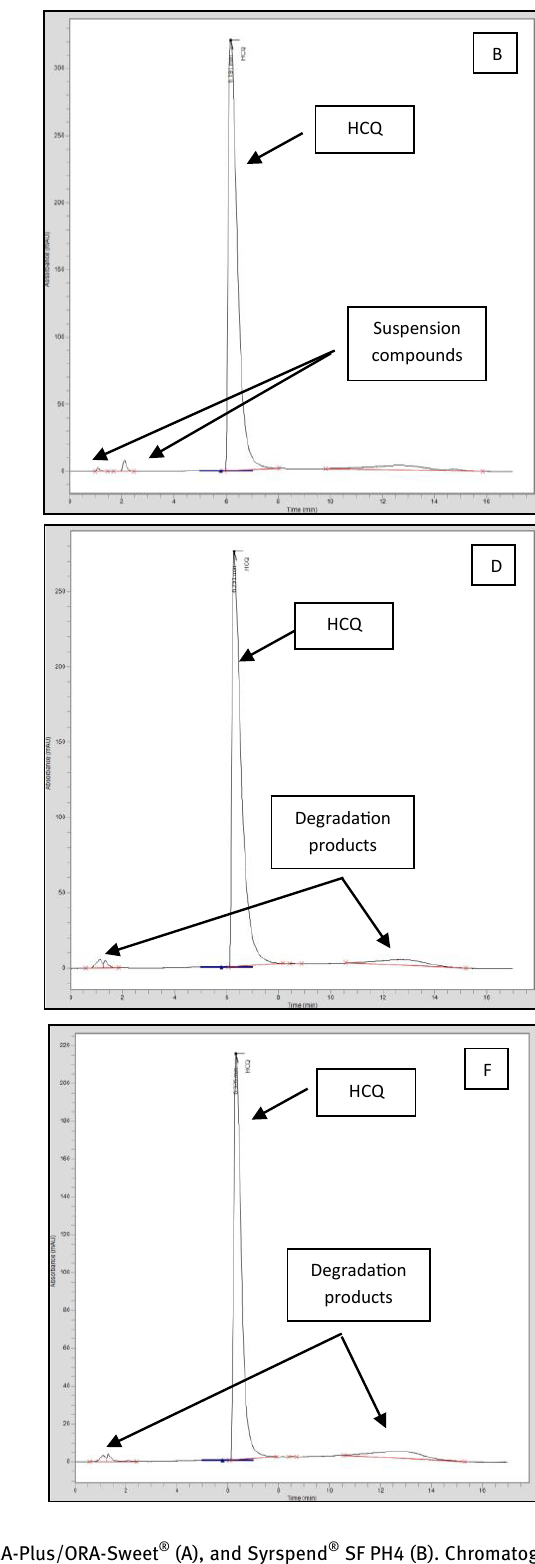
Figure 3: Chromatograms of fresh HCQ suspensions on ORA-Plus/ORA-Sweet ® (A), and Syrspend ® SF PH4 (B). Chromatograms of HCQ suspension on ORA-Plus/ORA-Sweet ® (C, E) and Syrspend ® SF PH4 (D, F), after stress degradation alkaline (NaOH, 1 M) associate with heat (80 ° C) respectively after 1 h (C, D) and 4 h (E,